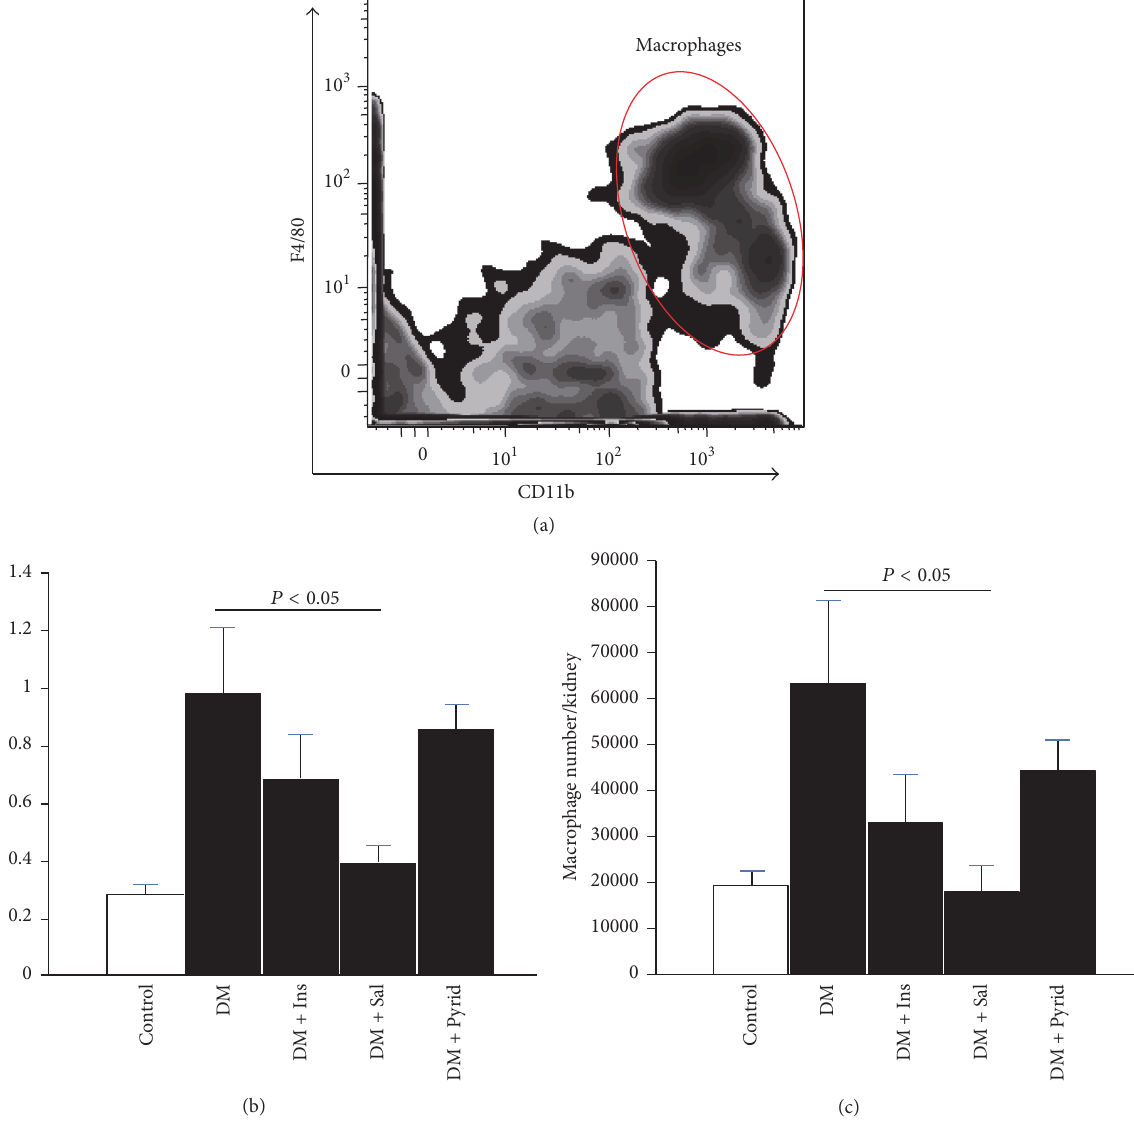
Figure 5: Flow cytometric data of kidneys. Macrophages were defined as PI − CD45 + CD11b + F4/80 + cells in the kidney. The final gating panel of CD11b- and F4/80-positive cell cluster is shown (a). Macrophage % in the kidney (b) and the total number of the macrophages (c) were calculated. Nondiabetic control (Control) ( 𝑛 = 8 ), diabetic mice without treatment (DM) ( 𝑛 = 19 ), diabetic mice with insulin treatment (DM + Ins) ( 𝑛 = 8 ), diabetic mice with salicylate treatment (DM + Sal) ( 𝑛 = 12 ), and diabetic mice with pyridoxamine treatment (DM + Pyrid) ( 𝑛 = 15 ). Values are mean ±